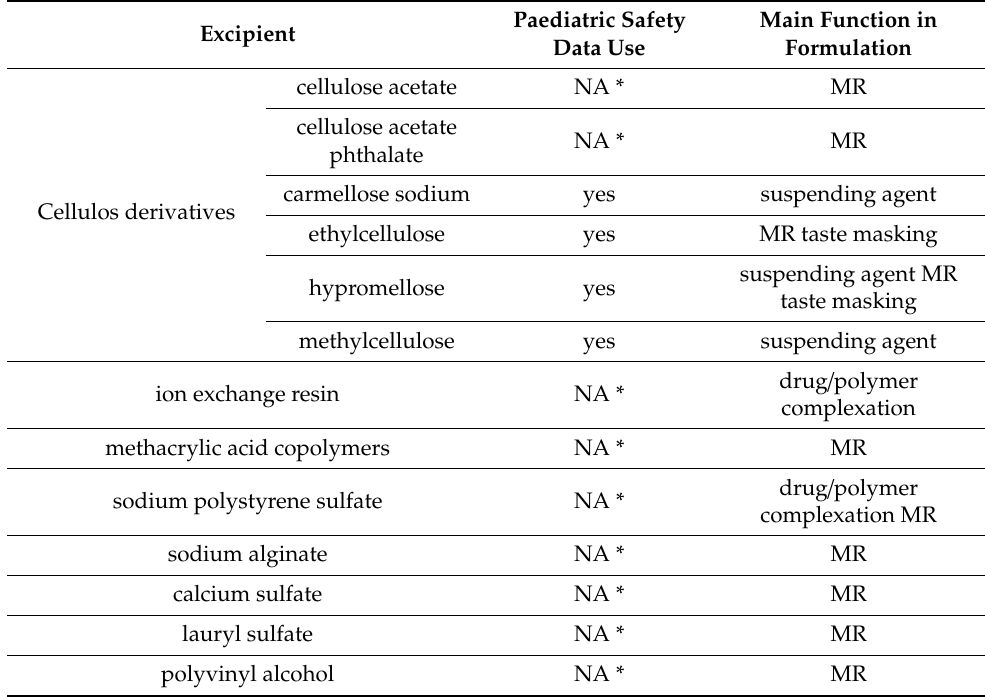
Table 3. Safety data of excipients used in paediatric modified release preparation